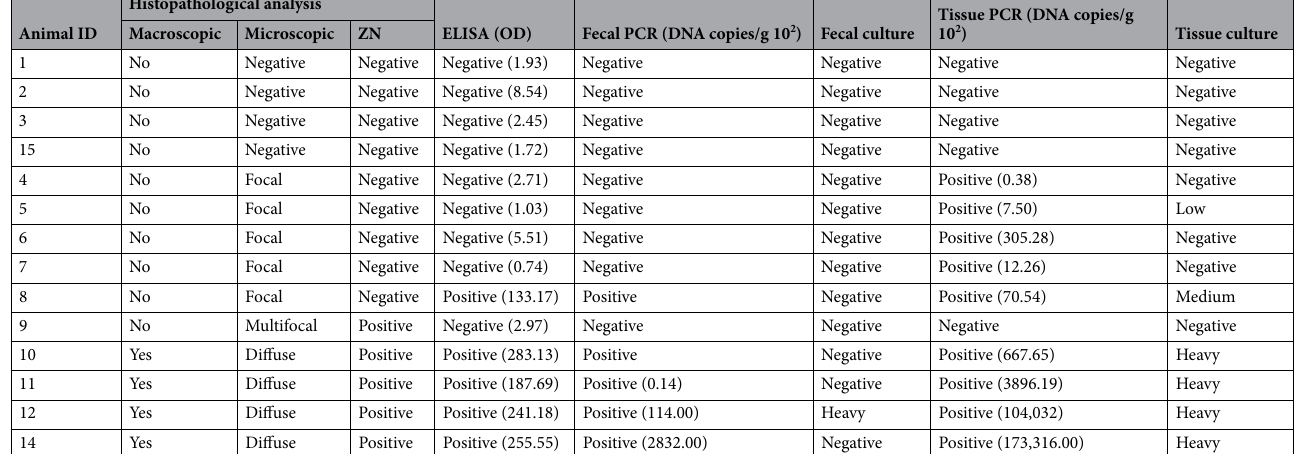
Table 1. Histopathological analysis, ELISA, PCR, and bacteriological culture results from all the animals included in the current study. DNA samples with a PCR-positive result using the LSI VetMax Triplex